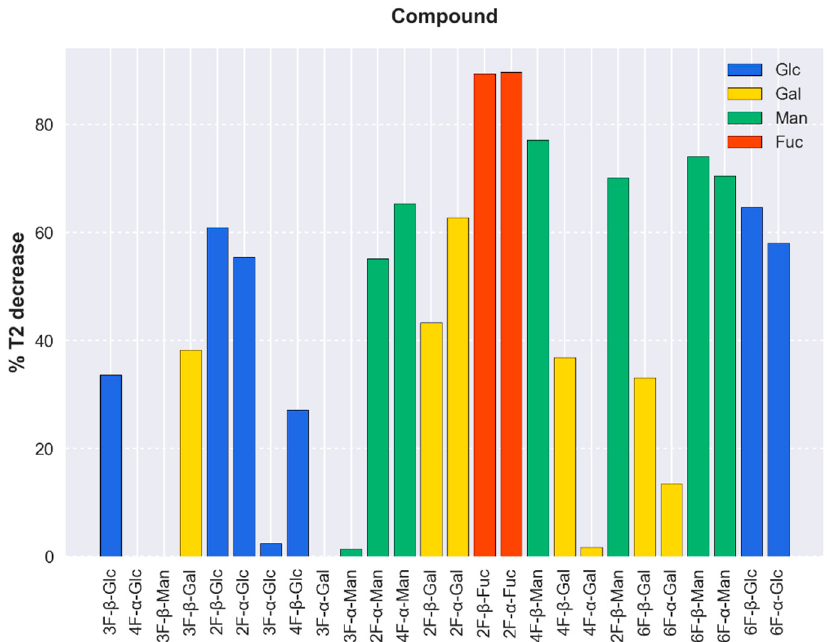
Figure 3. Percentage of decrease of the T 2 values between the free and bound states of the fluorine-containing monosaccharide library obtained from the 19 F Carr-Purcell-Meiboom-Gill (CPMG) experiments. In this particular case, the ligand / DC-SIGN ratio was 47:1. Binders of the lectin display a remarkable decrease in the normalized T 2 values, above 40%. Qualitatively, very weak or non-binders show decreases below 40%. The order in the x-axis corresponds to the 19 F chemical shift. The molecule whose 19 F signal displays the lowest field chemical shift is at the left, while that whose 19 F signal is at the highest field chemical is at the right.